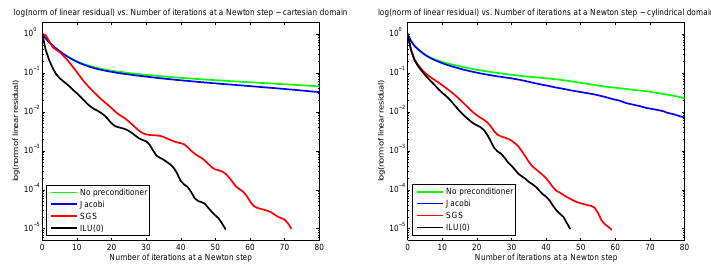
Figure 12. Linear convergence histories of various preconditioners for Re = 160 . Cartesian on the left, Polar on the right.